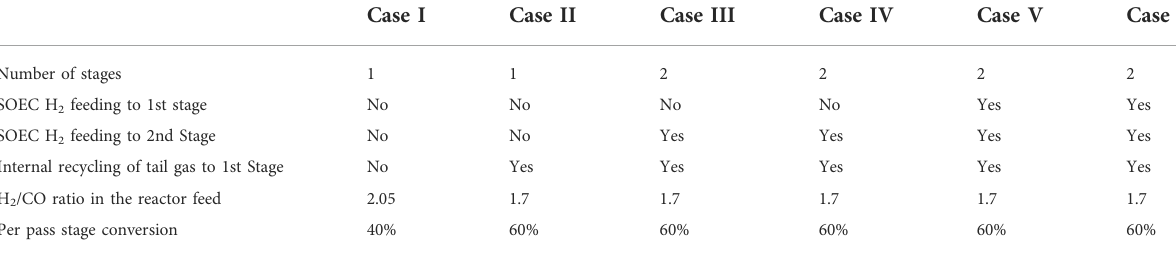
TABLE 2 Process steps applicable for different Cases in the fuel synthesis